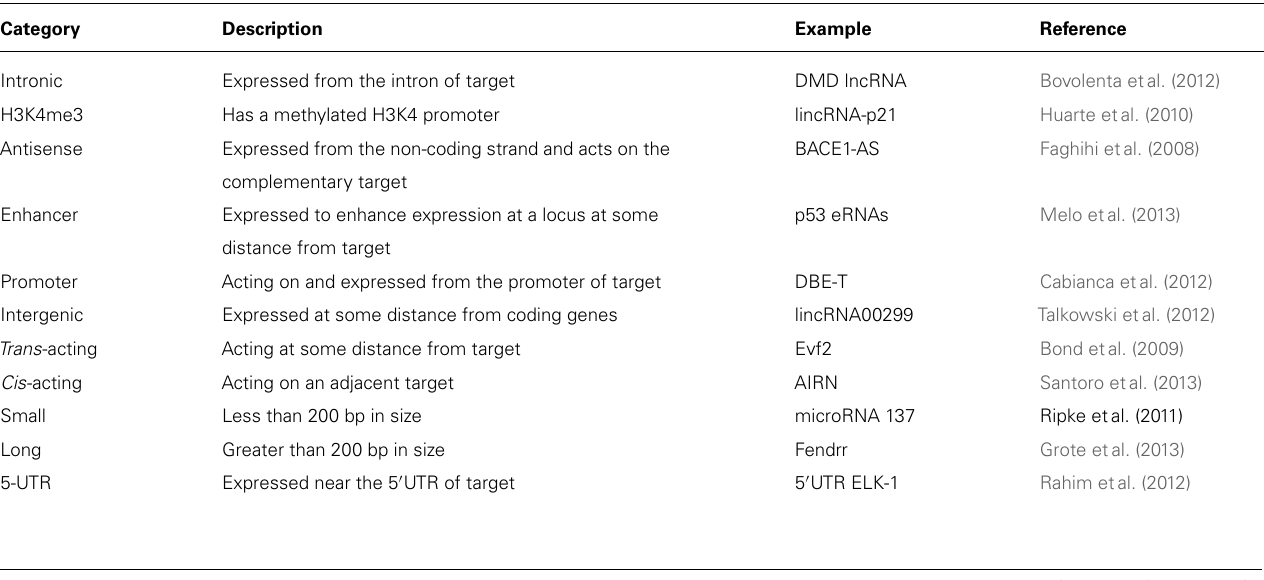
Table 1 | Some examples of categorization of non-coding